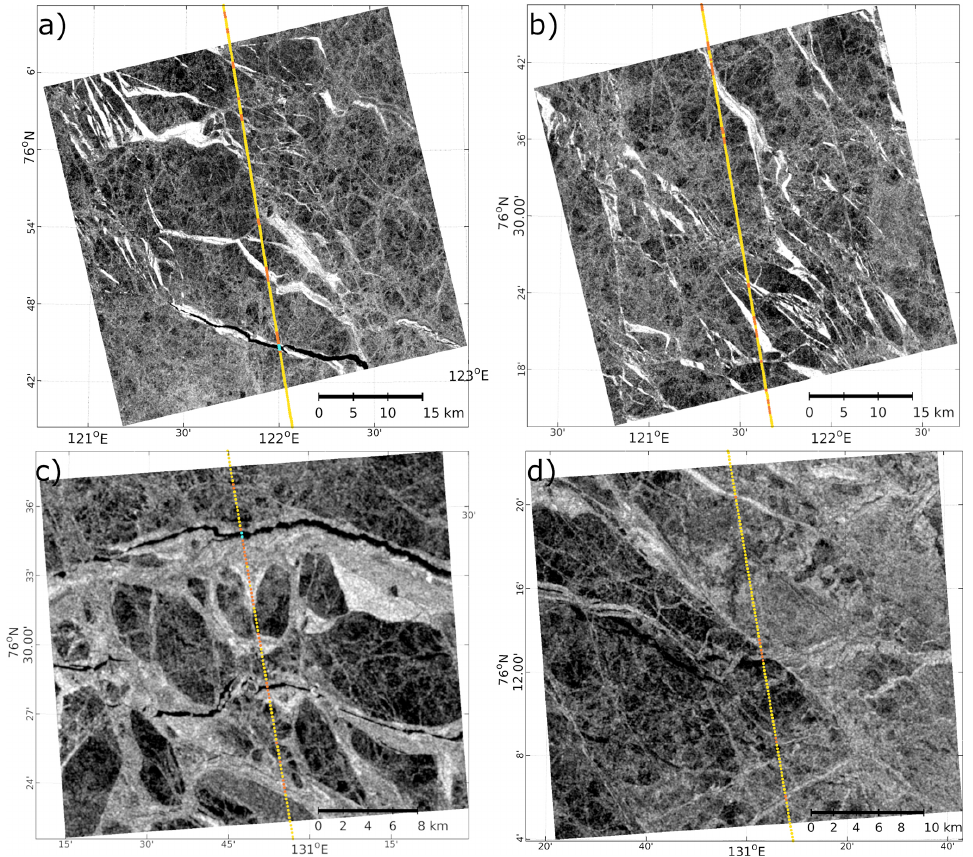
Figure 4. Examples of classified CryoSat-2 observations versus HH-polarized Sentinel-1B (a, b) and Sentinel-1A (c, d) snapshots from February 2018 with acquisition time gaps of about 2 and 1min, respectively. Orange markers show thin-ice classifications. Leads are labelled in cyan, and sea ice is in yellow. Figures are